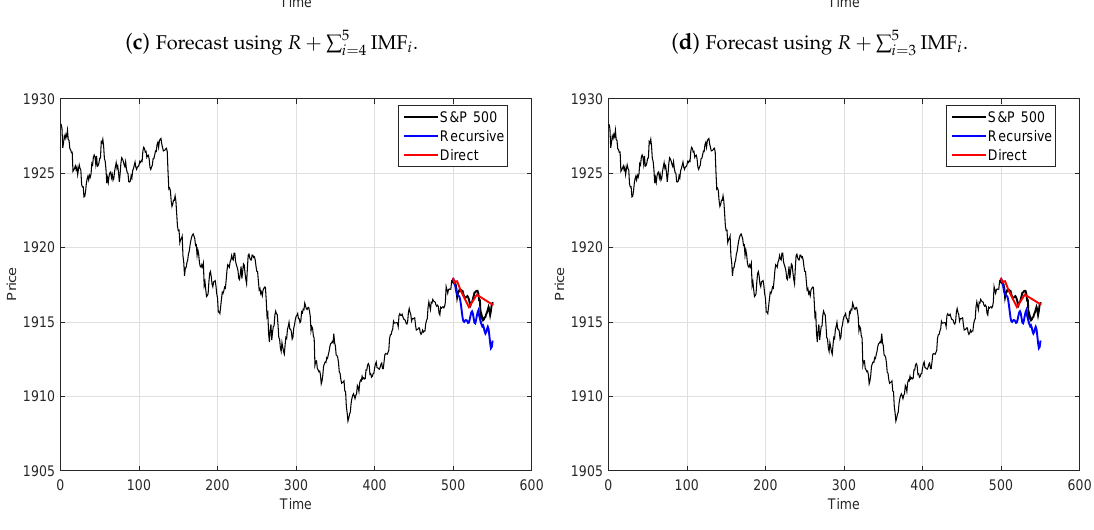
( e ) Forecast using R + ∑ 5